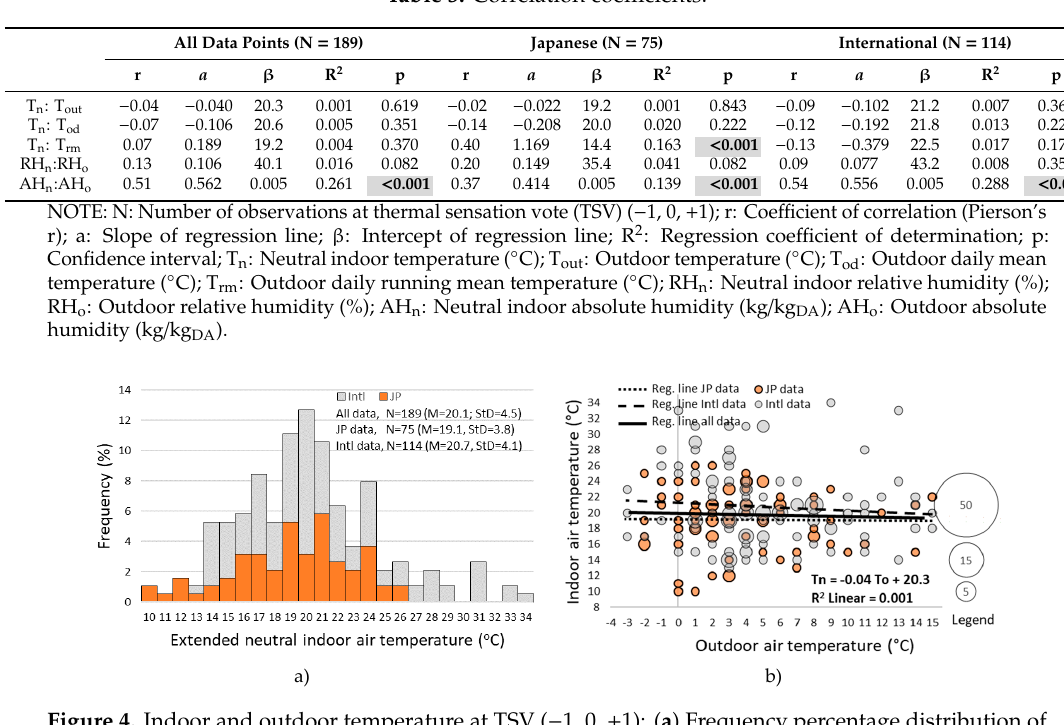
Figure 5. Indoor and outdoor relative humidity at TSV ( − 1, 0, +1): ( a ) Frequency percentage distribution of neutral indoor relative humidity; ( b ) correlation between indoor and outdoor relative humidity at the vote.